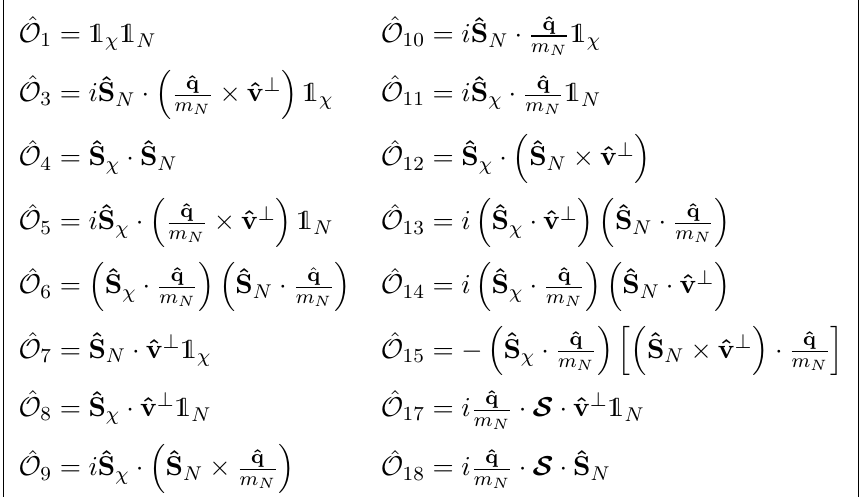
Table 2 . Quantum mechanical operators de(cid:12)ning the non-relativistic e(cid:11)ective theory of DM- nucleon interactions [39]. The operators are expressed in terms of the basic invariants under Galilean transformations: the momentum transfer, ^ q , the transverse relative velocity operator ^ v ? , the nucleon and DM spin operators, denoted by ^ S N and ^ S (cid:31) , respectively, and the identities in the nucleon and DM spin spaces, 1 (cid:31) and 1 N . All operators have the same mass dimension, and m N is the nucleon mass. Standard spin-independent and spin-dependent interactions correspond to the operators ^ O 1 and ^ O 4 , respectively, while S is a symmetric combination of spin 1 polarisation vectors [29]. The operators ^ O 17 and ^ O 18 can only arise for spin 1 DM. Following [39], here we do not consider the interaction operators ^ O 2 and ^ O 16 : the former is quadratic in ^ v ? (and the e(cid:11)ective theory expansion in [39] is truncated at linear order in ^ v ? and second order in ^ q ) and the latter is a linear combination of ^ O 12 and ^ O 15